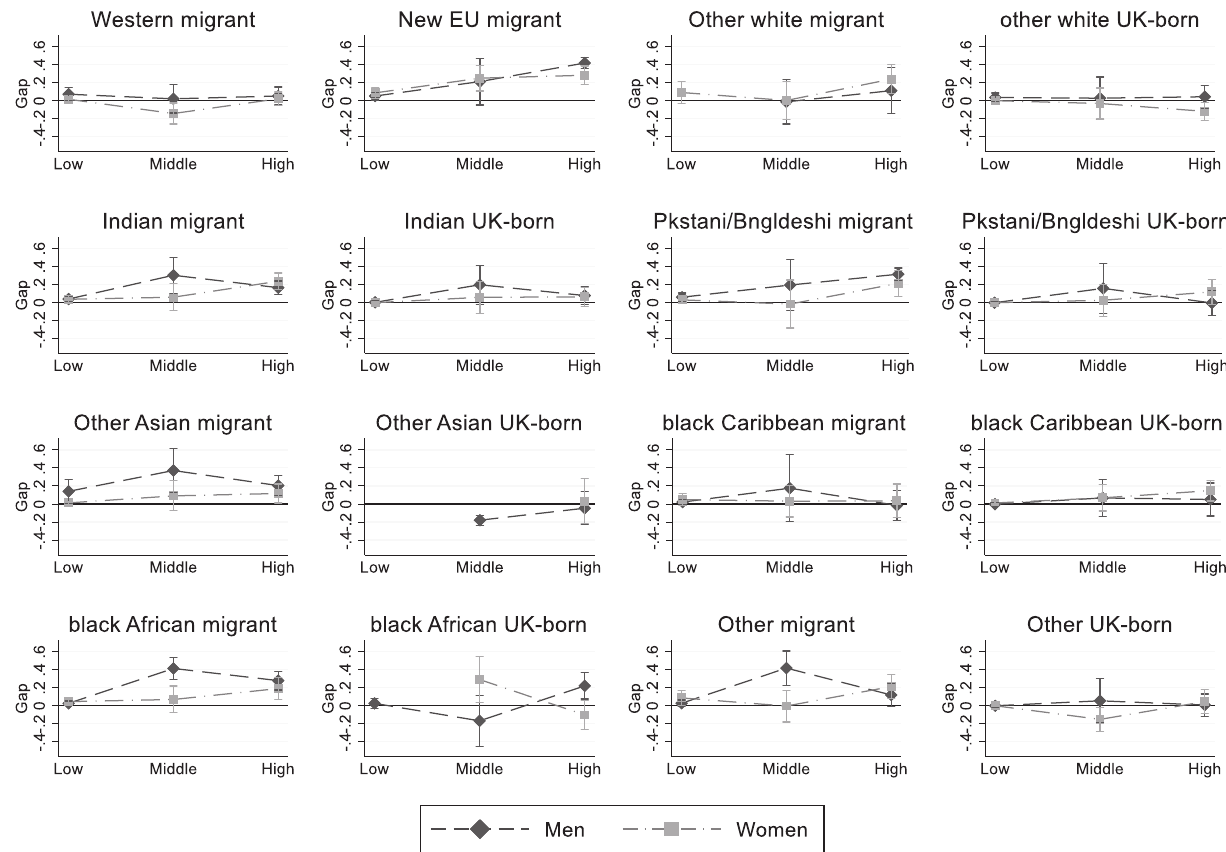
Figure 2. Estimated difference (95% Confidence interval) from white British majority in probability of being over-qualified. Source: Understanding Society 2009–2017 (Knies, 2017), showing the estimated difference in predicted probability at grand margin for origin groups from white British majority by qualification (low: at most upper secondary, middle: post- secondary non-tertiary, or high: tertiary) from weighted binary logistic regression model with clustered standard errors by person. Note: Models control for age (squared), urban, cohabiting, dependent child, poor health, fixed effects for year of survey and government office region, and include qualifications and origin